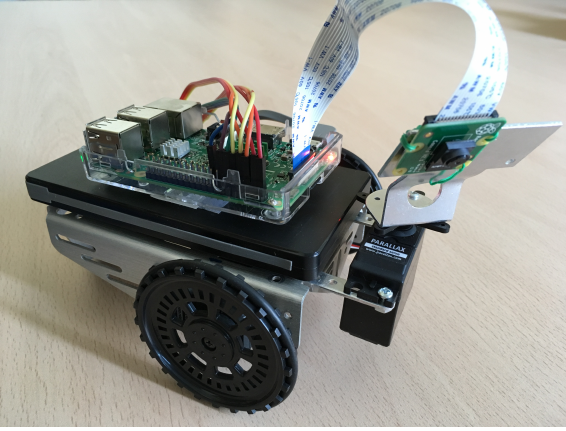
Figure 4. PiBot with its PiCamera mounted on a Pan Unit.